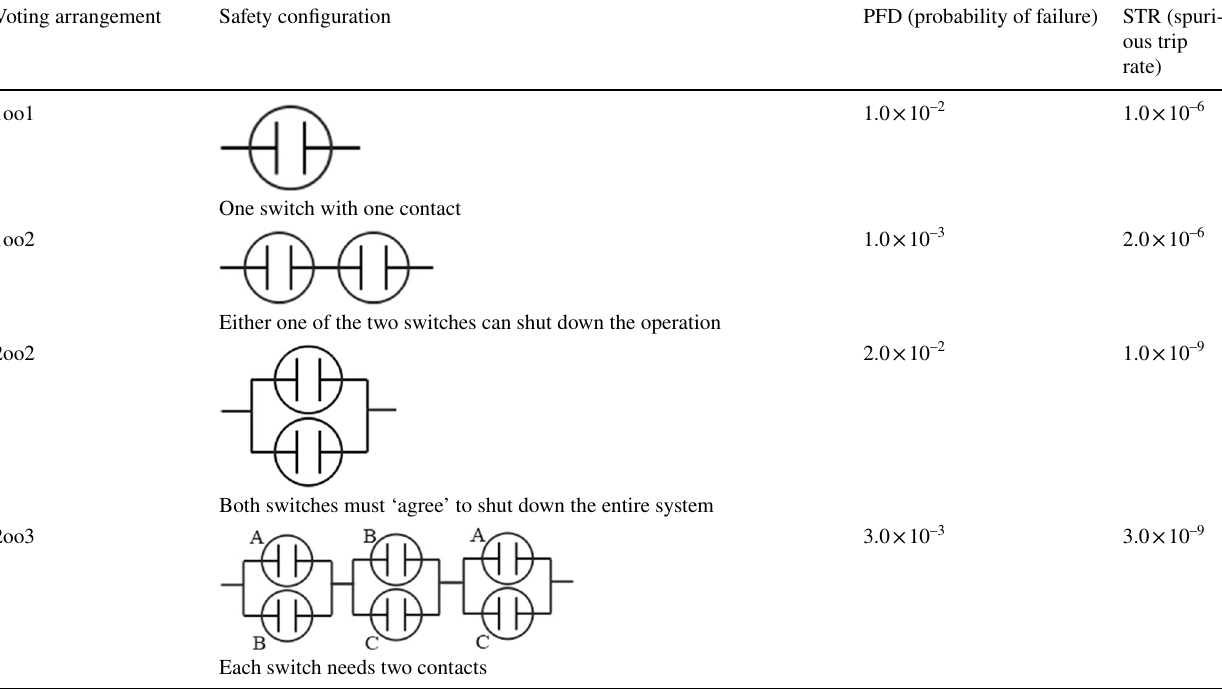
The PFD and STR values are for